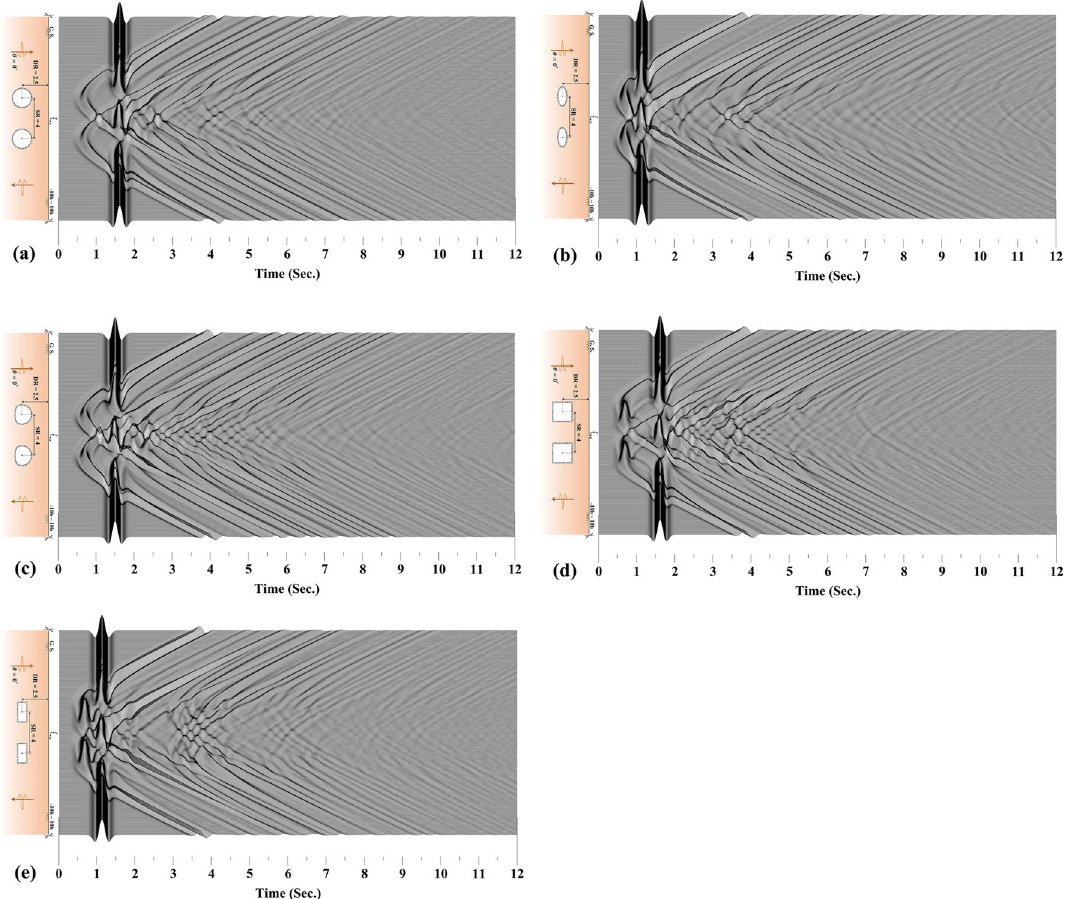
Fig. 2 Synthetic seismograms of the ground surface and the procedure of the SH waves’ dispersion with time, for the model of twin a circu- lar-, b elliptical-, c horseshoe-, d square- and e rectangular-shaped lined tunnels subjected to vertical incident